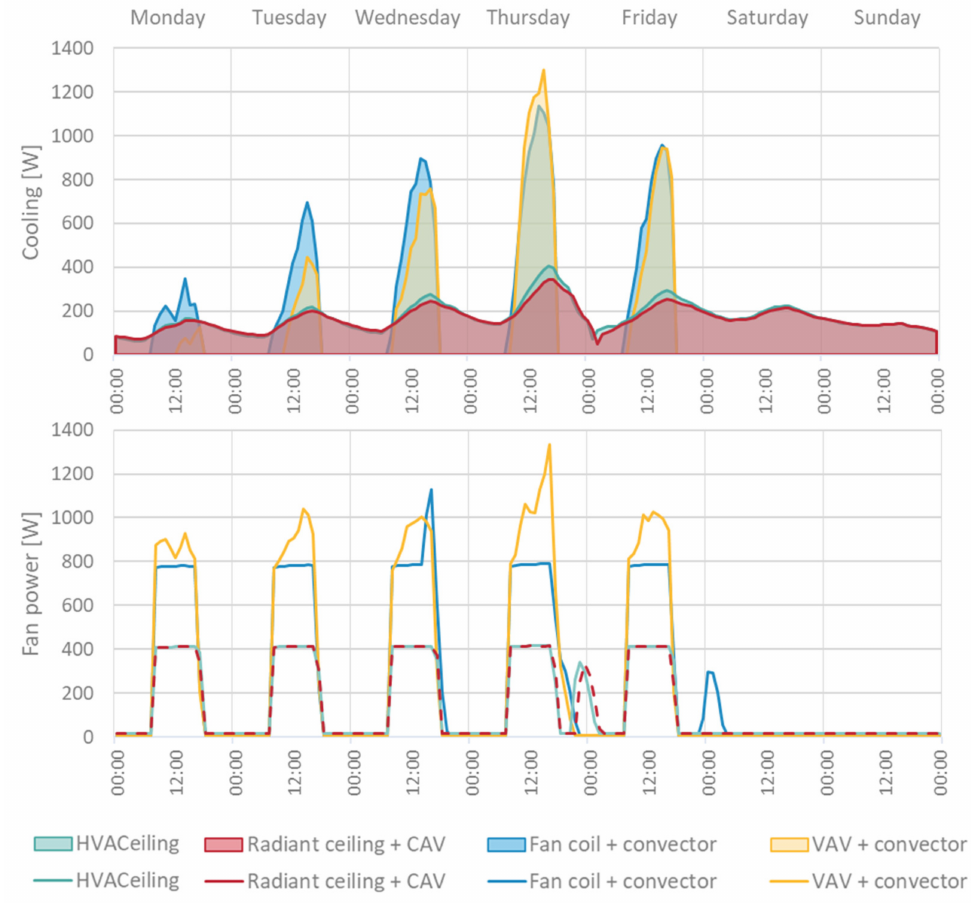
Figure 12. Peak electric cooling and fan power in a warm week of July (12th–18th). Sum of hourly values for all six rooms over one